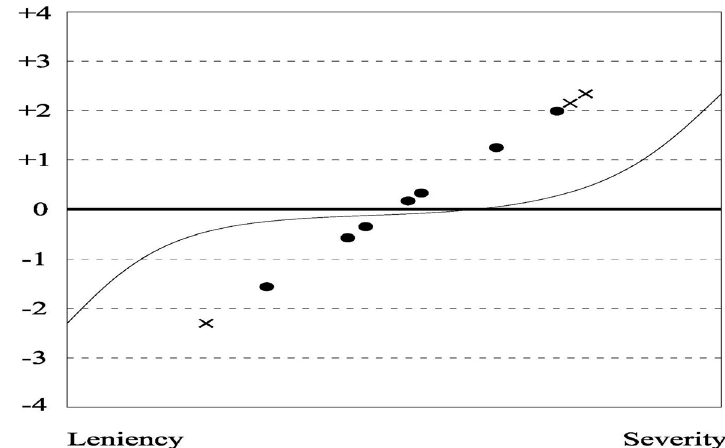
Fig. 8 Old raters’ bias interaction (delayed post‑training)